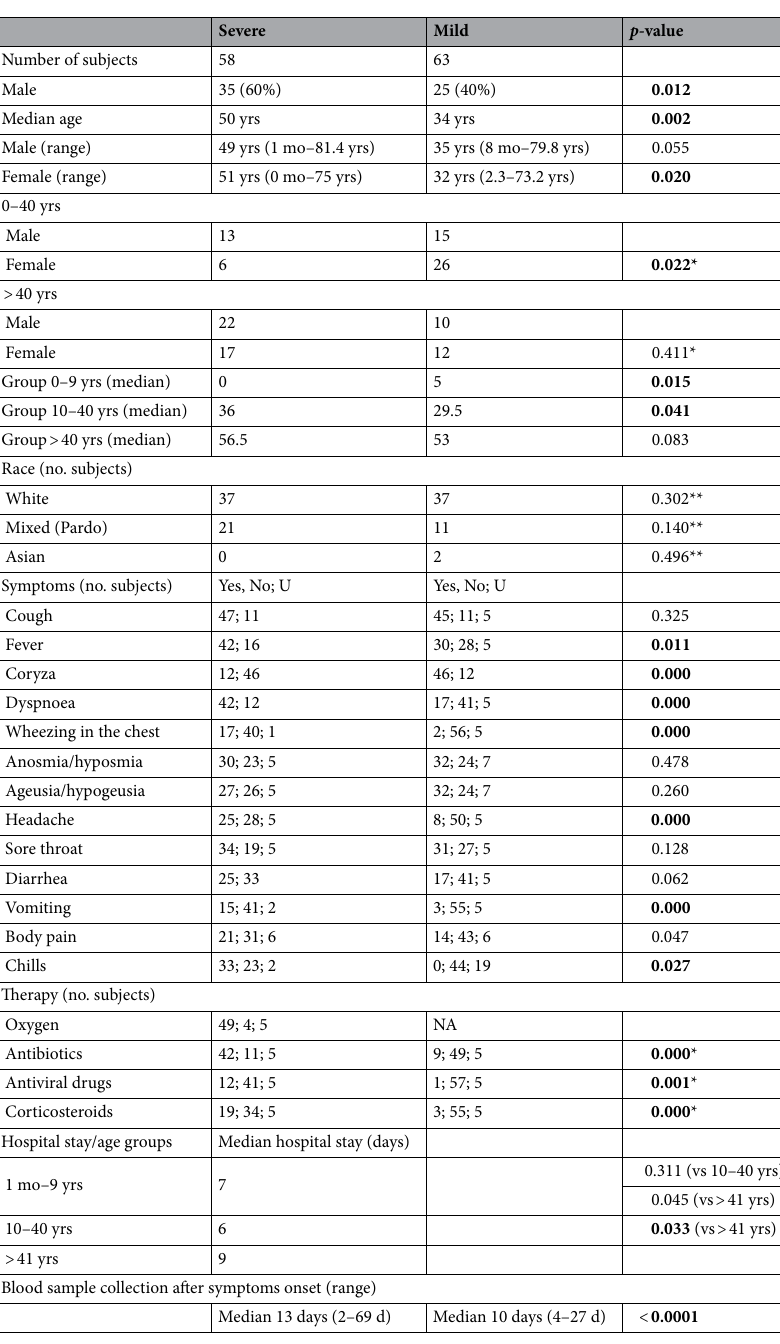
Table 1. Clinical and demographic characteristics of the COVID-19 hospitalized (Severe group) and oligosymptomatic (Mild group) patients. U unknown, NA not applicable, mo months, yrs years, d days. Thirteen patients in the Mild group opted for not answering the question relative to race. All statistical analyses were performed using Mann Whitney test, except for the analyses indicated by * or ** where Chi-square or Fisher exact tests were used. In bold, significant p -values <